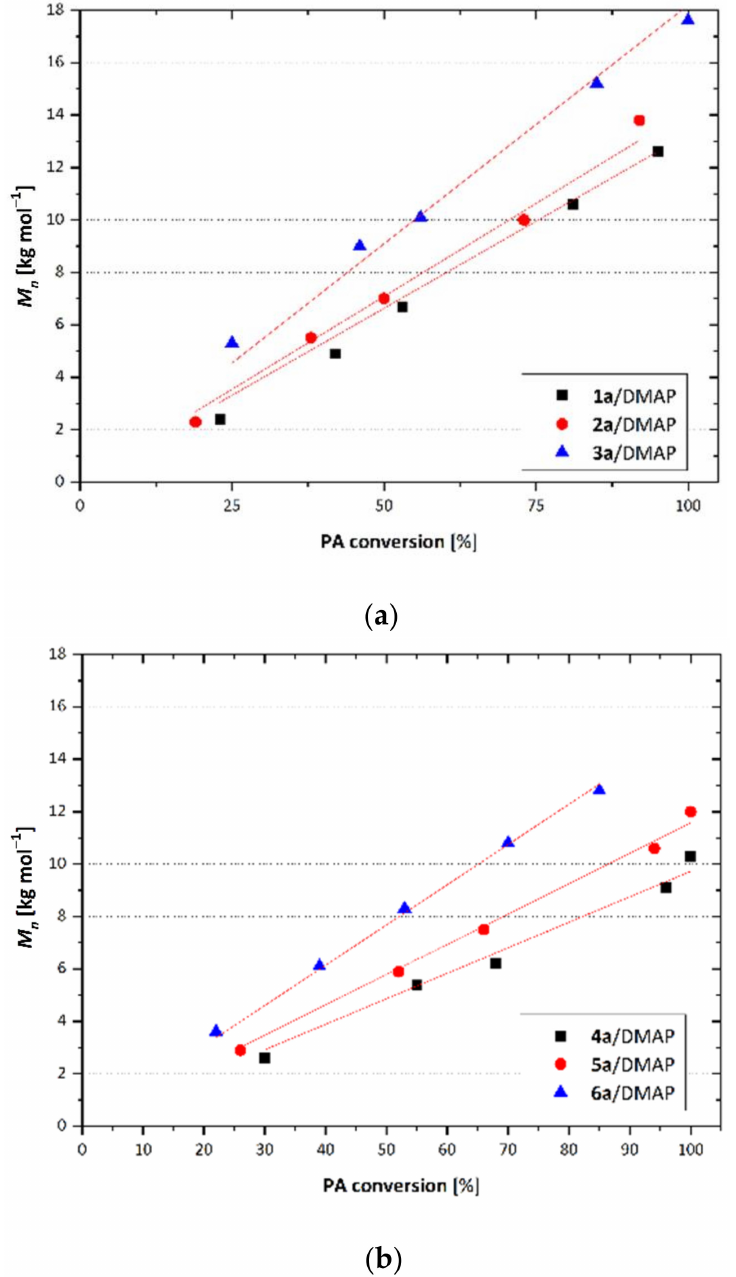
Figure 3. Relationships between the M n and PA conversion for complexes 1a–6a in the ROCOP of PA and CHO: ( a ) R 1 -X = CH 2 NMe 2 , ( b ) R 1 -X = CH 2 OMe (reaction conditions: 110 ◦ C, 2.5 mmol PA and 2.5 mmol CHO in 0.5 mL of toluene, and initial molar ratio of [PA] 0 :[CHO] 0 :[Cr] 0 :[DMAP] 0 = 250:250:1:1). The results of GPC analysis performed for the products obtained in 240-min exper- iments did not show the effect of the type of pendant group R 1 -X on the dispersity ( Ð ) of the molecular mass of the resulting polyesters. All polyesters that were obtained by equal to about 1.2, independently of the pendant group structure (Table 2, Runs 5, 20, complexes 2a and 5a with R 2 = OMe. Independently of the nature of a pendant group (R 1 -X = CH 2 -NMe 2 or CH 2 -OMe), the value of Ð amounted to 1.2 (Table 2, Runs 10